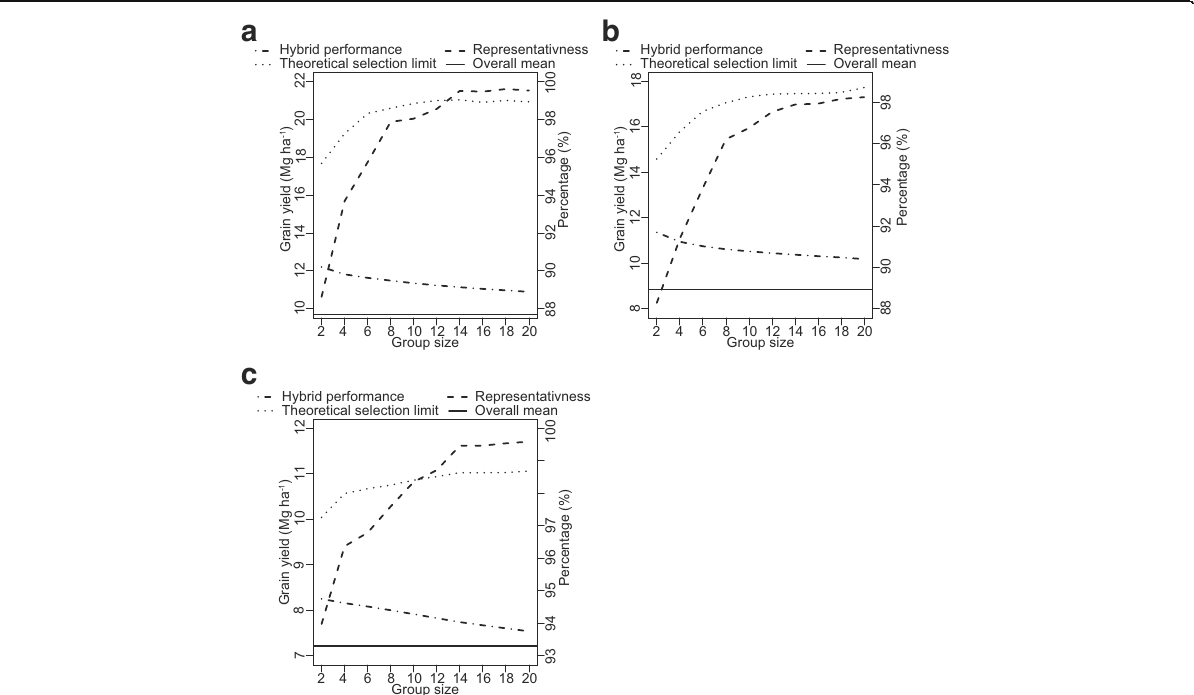
Fig. 4 Short- (Hybrid performance) and long-term success (Representativeness, Theoretical selection limit) in dependence of heterotic group size for market segments ( a ) LS, ( b ) MM, and ( c ) SS